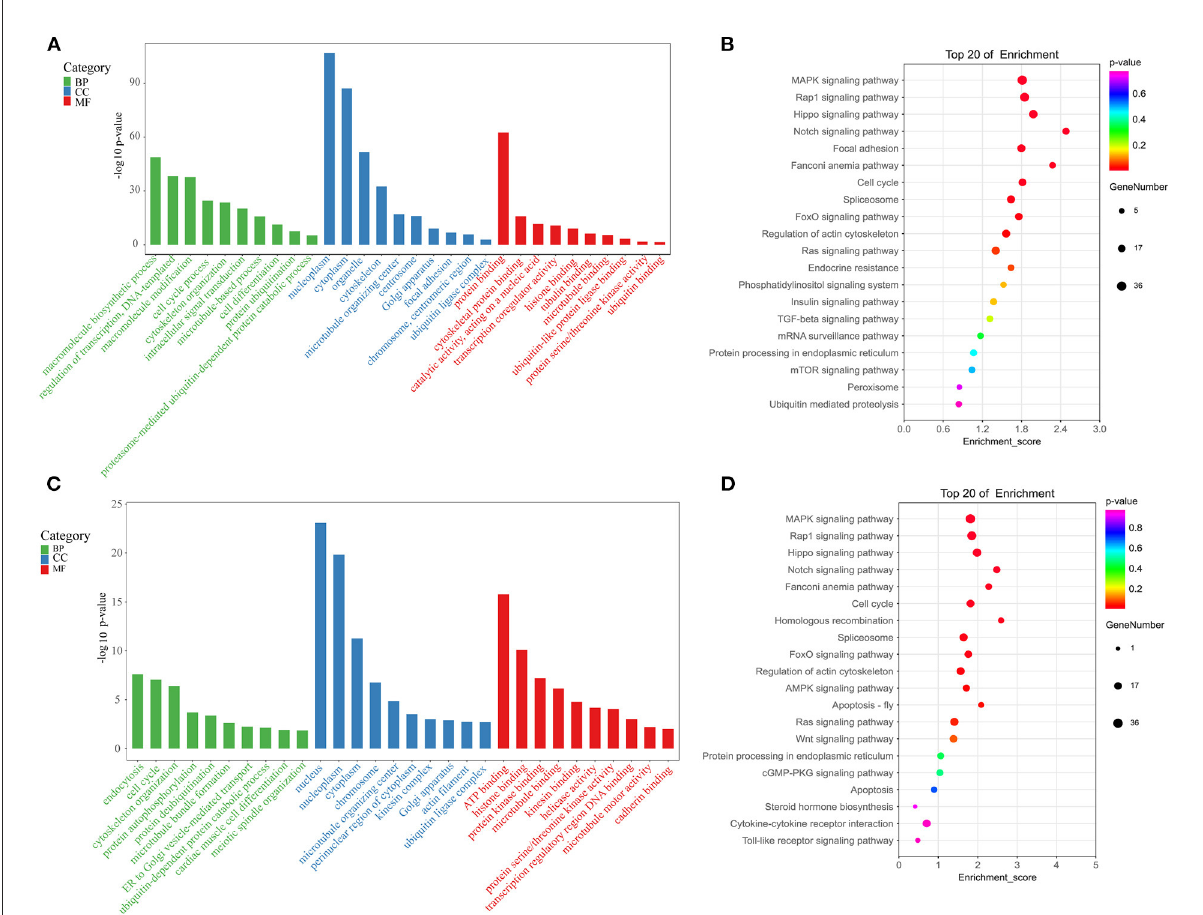
FIGURE5 Enrichment analyses. (A) GO analyses for the T vs. Y group. (B) KEGG analyses for the T vs. Y group. (C) GO analyses for the T vs. M group. (D) KEGG analyses for the T vs. M group.